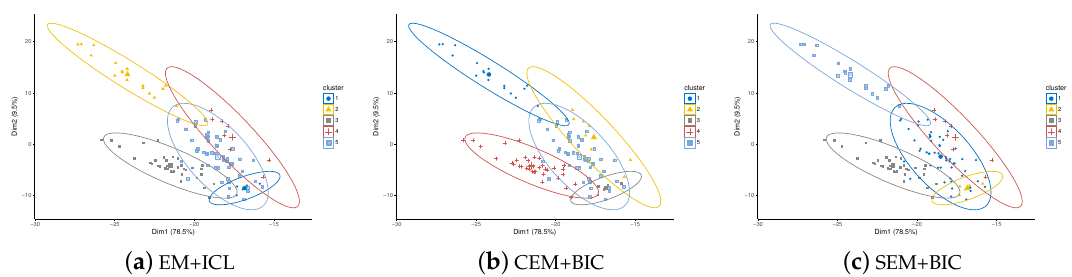
Figure 6. Illustration of clustering alignment issue: HDDC clusterings on SFD-out data with EM, CEM or SEM models using either ICL or BIC report identical K = 5 clusters. Cluster plot is visualized using the factoextra package in